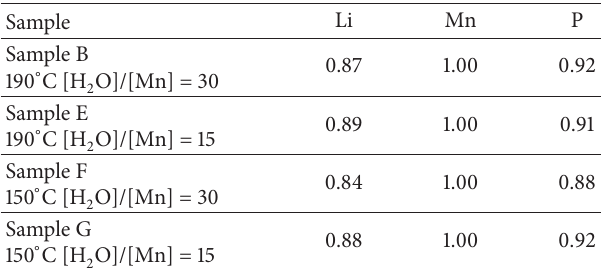
synthesized with various parame-